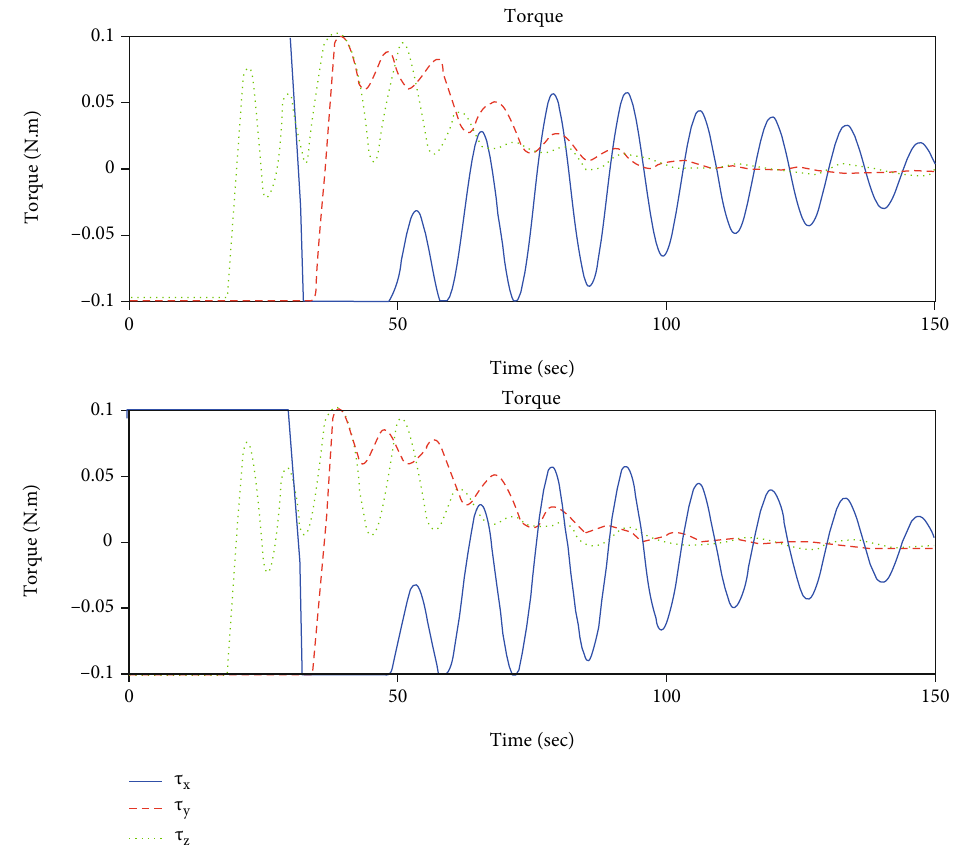
Figure 5: Time histories of control forces and torques expressed in the body- fi xed